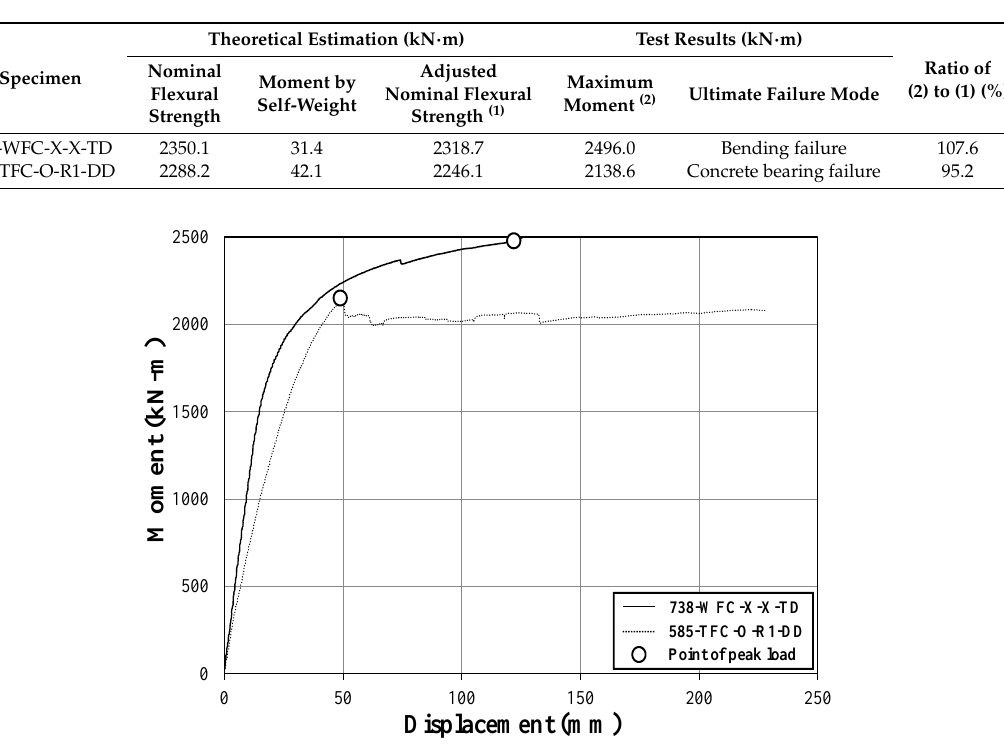
Figure 15. Load versus displacement curves of the fully composite specimens.